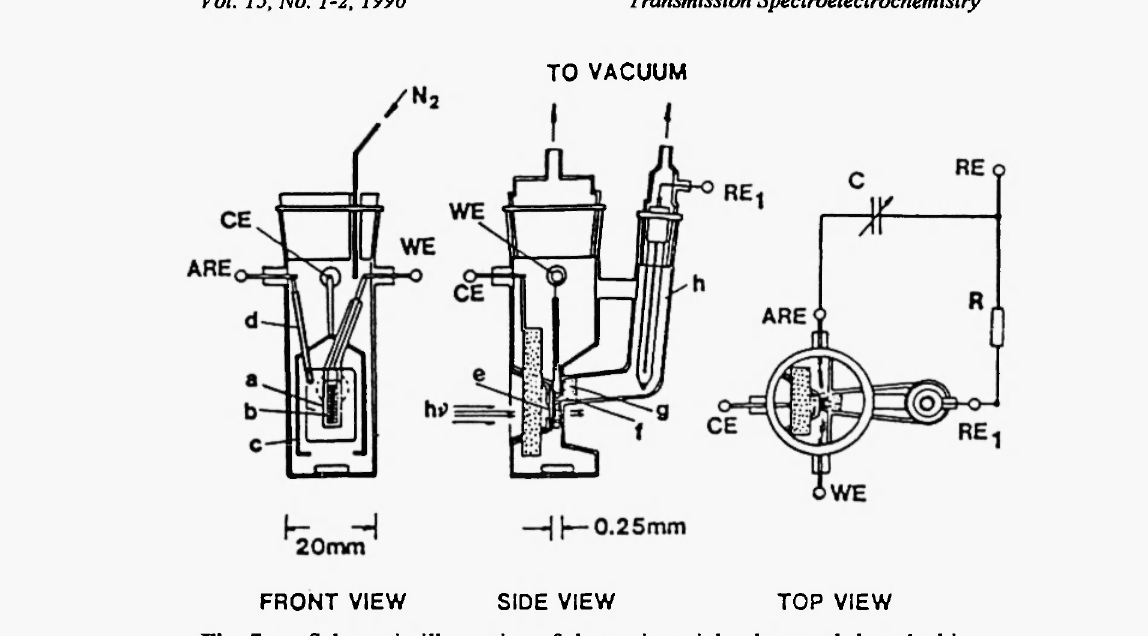
Fig. 7: Schematic illustration of the vacium tight short path length thin- layer spectroelectrochemical cell with a doublet platinum gauze working electrode. The side view shows how the cell works in acquiring spectral data. The top view shows the connecting of the outer RC circuit. The symbols are as follows: (a) thin-layer chamber, (b) double platinum gauze working electrode with edge eliminator, (c) expanded platinum metal counter electrode, (d) platinum wire auxiliary reference electrode, (e) photo window, (f) reference point, the tip of the frit, (g) asbestos spot, (h) reference frit. CE-count electrode post, WE-working electrode post, Rei - Ag/AgCl reference electrode, ARE-auxiliary reference electrode post, Re-reference electrode post. (From